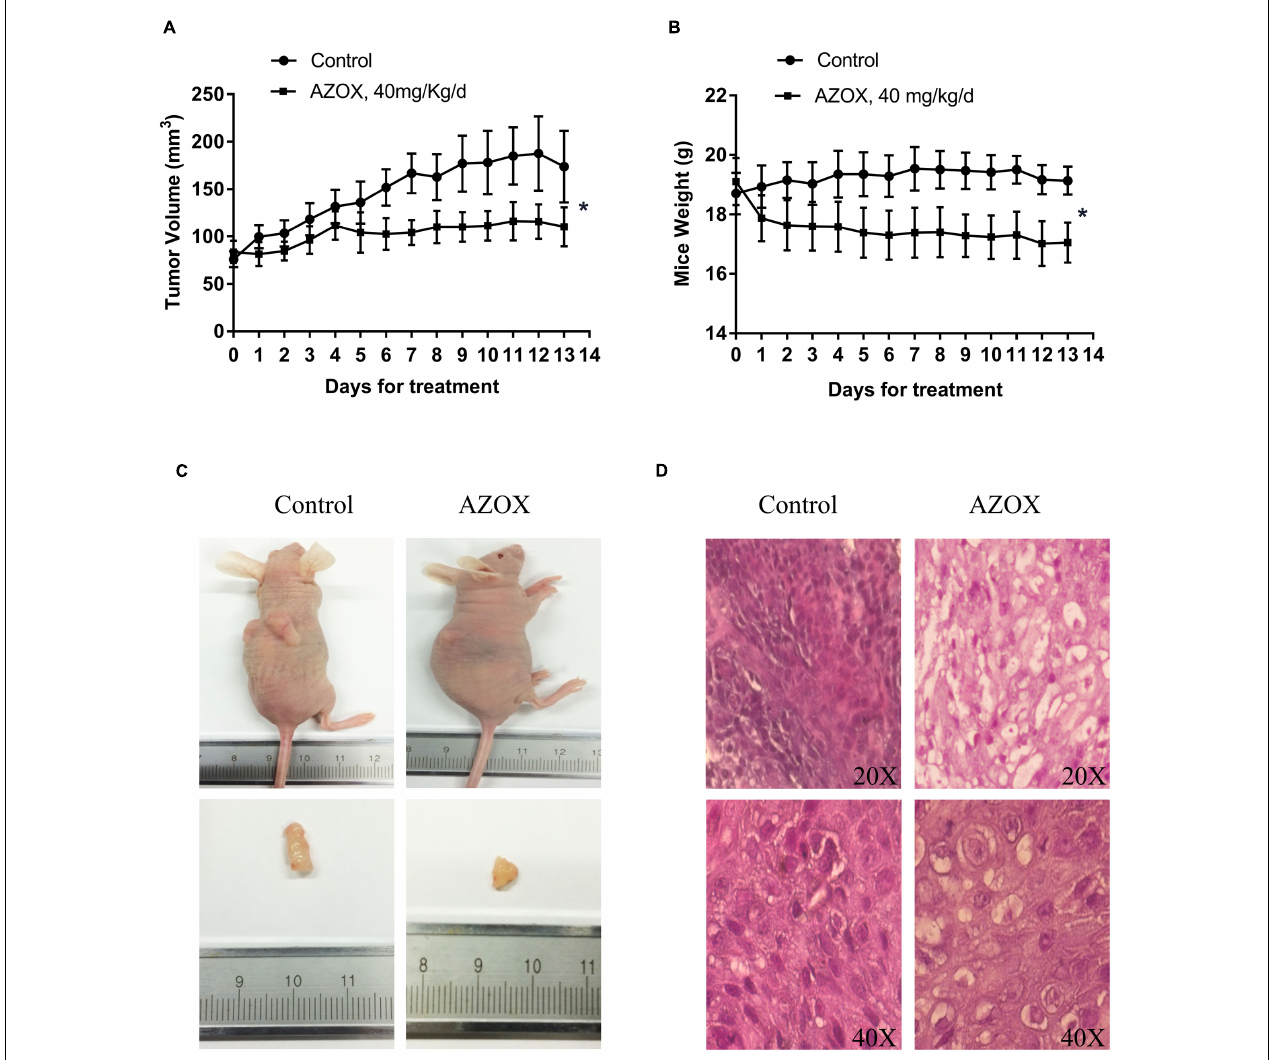
FIGURE 5 | AZOX inhibited the in vivo tumor growth in nude mice. Nude mice transplanted with KYSE-150 xenografted tumors were intragastric administrated with vehicle or AZOX 40 mg/kg/day for 13 days. (A) The growth curves of tumor volume between the control group ( n = 6) and AZOX group ( n = 6). (B) Comparison of the mice body weight between control and AZOX group. The weight of the nude mice was weighted and recorded every day from the 1st day of AZOX treatment. (C) The representatives of the control and AZOX-treated mice and tumors. At the end of the experiment, mice were anesthetized with chloral hydrate, the tumor and the mice were weighted and photographed. (D) Representative hematoxylin and eosin (H&E) staining of the xenografted tumors of control and AZOX group. The tumors were dehydrated, fixed, and sectioned, and then stained with H&E to identify the proliferation of the cancer